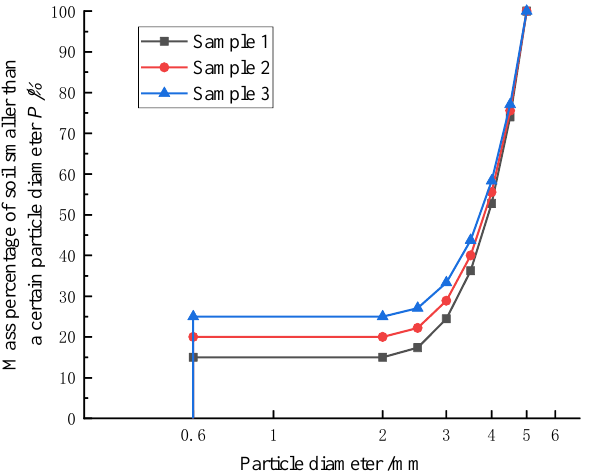
Figure 2. Particle gradation used in the simulation. Table 1. Table of model parameters.